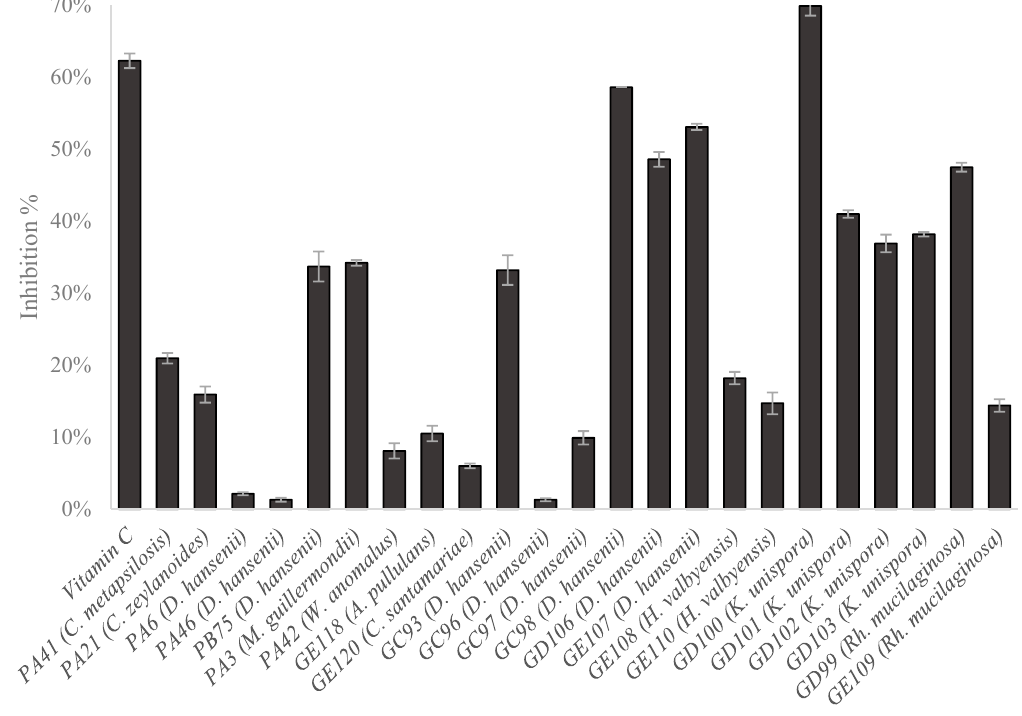
Figure 4. Lipid peroxidation (% inhibition) of the yeast strains studied and positive control (Vitamin D). Strains with code PA means yeasts strains from factory A (Pork), while GC, GD, GE codes indicated strains from game meat samples from factory C (GC), D (GD) and E (GD). In general, 25% of the strains from pork fermented sausages presented this capacity, while around 80% was shown in game meat sausages. Only one strain ( K. unispora GD100) showed 69.9%, which was higher than the positive control (62.3%). As occurred in the antioxidant activity assay, the anti-lipid peroxidation capacity has turned to be strain